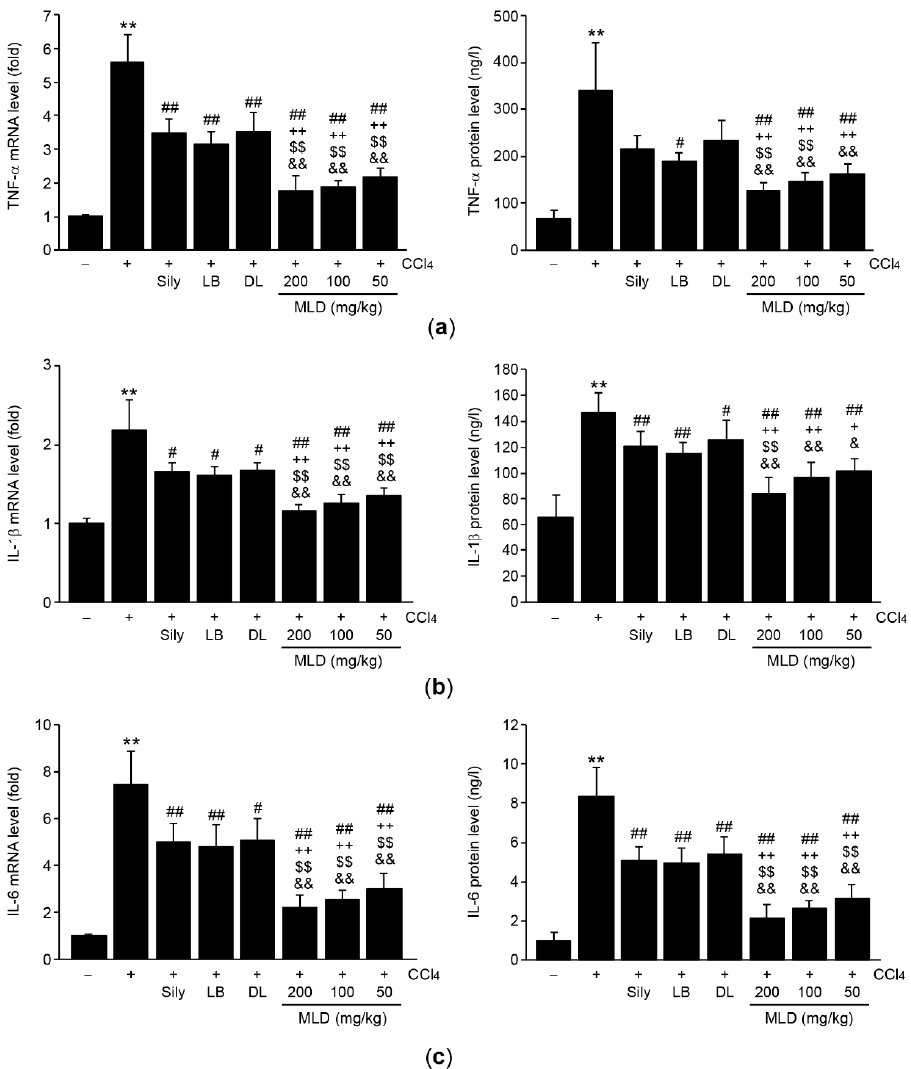
Figure 6. MLD inhibits the production of proinflammatory cytokines in CCl 4 -treated mice. Levels of mRNA (left) and proteins (right) of TNF- α ( a ), IL-1 β ( b ), and IL-6 ( c ) in the liver were determined using real-time PCR and ELISA, respectively. All values are expressed as mean ± SD of ten mice. ** p < 0.01 between the vehicle and CCl 4 groups; ## p < 0.01, # p < 0.05 versus CCl 4 -injected mice; ++ p < 0.01, + p < 0.05 between Sily- and MLD-treated mice; $$ p < 0.01 between LB- and MLD-treated mice; && p < 0.01, & p < 0.05 between DL- and MLD-treated mice.